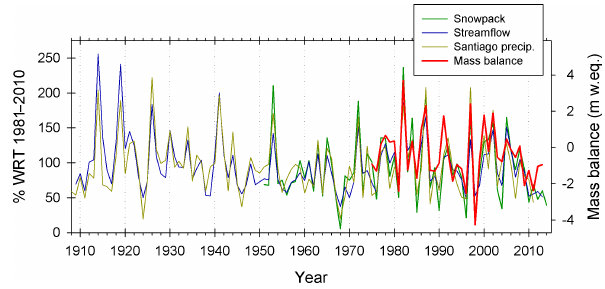
Figure 2. Comparison between the annual mass-balance series of ECH and regional records of maximum winter snow accumulation and mean annual river discharges in the Andes between 30 and 37 ◦ S (see Fig. 1). The regional records are expressed as percent- ages with respect to the 1981–2010 mean values. Variations in an- nual total precipitation at Santiago are also included to highlight the strong common hydroclimatic signal in this